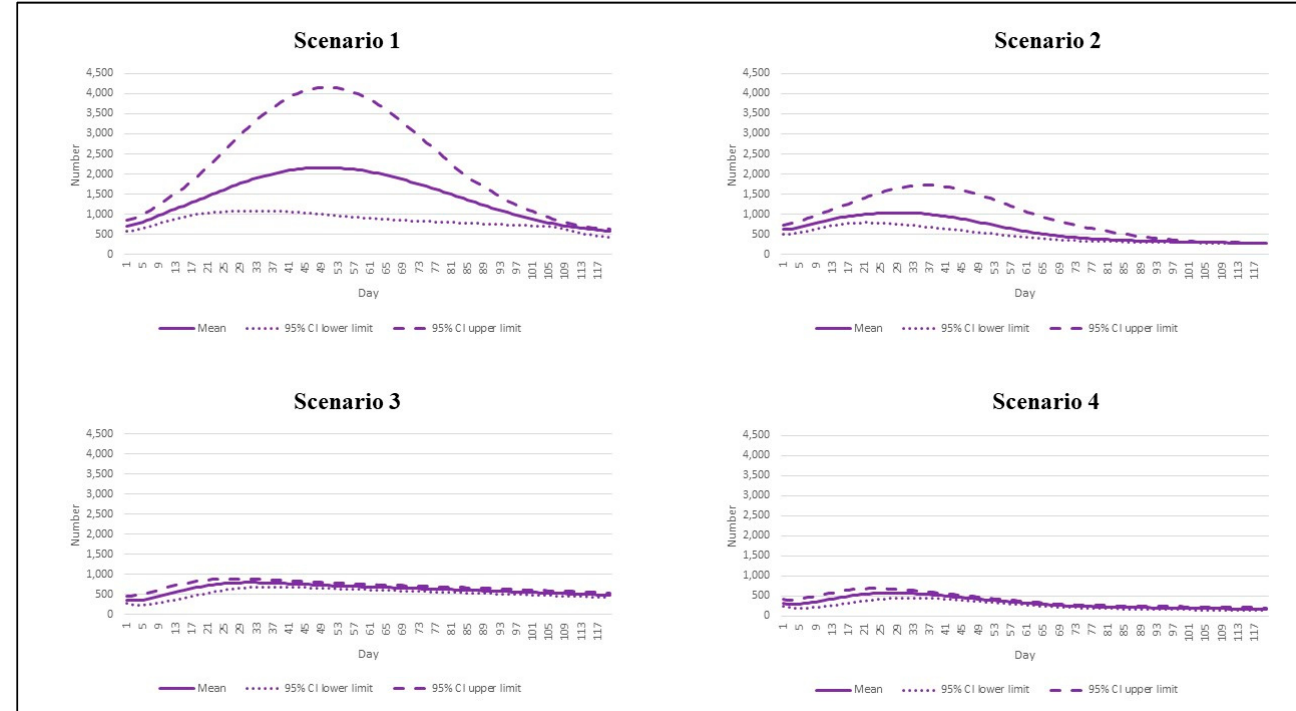
Figure 4. The prevalent intubated cases by different epidemic scenarios.